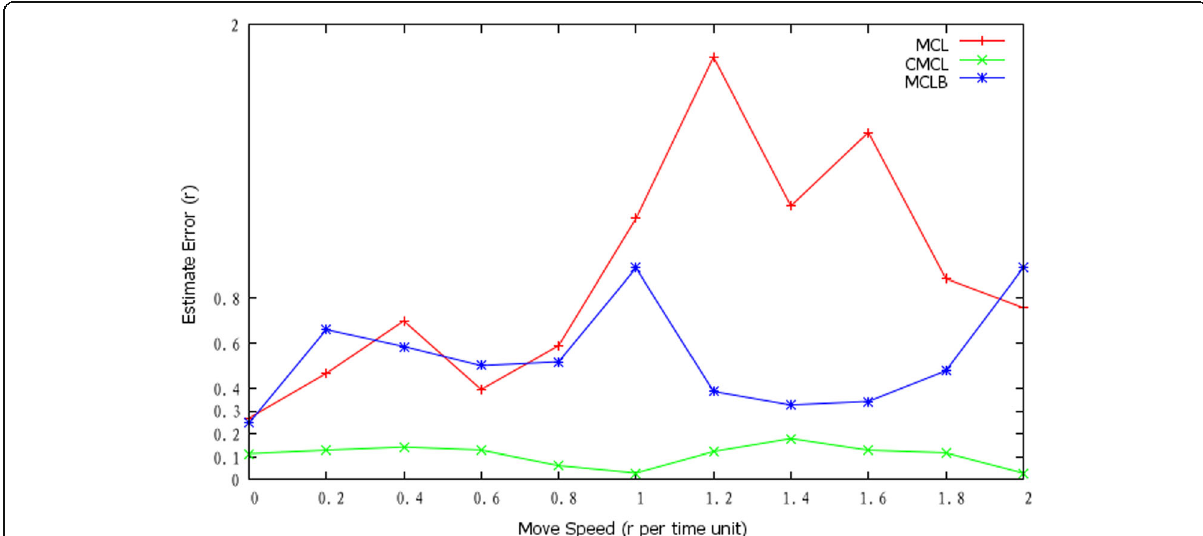
Fig. 4 Anchor node by 50-m interval comparison chart. From the top anchor node, the spacing was 50 m, charting to see when a node ’ s moving